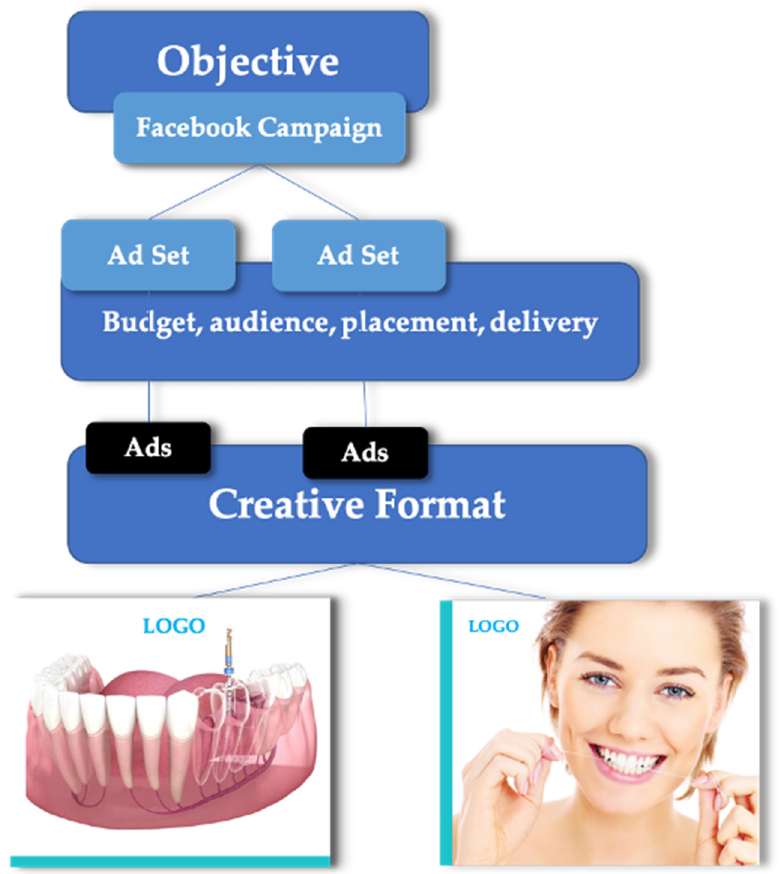
Figure 2. The structure of the Facebook campaign.